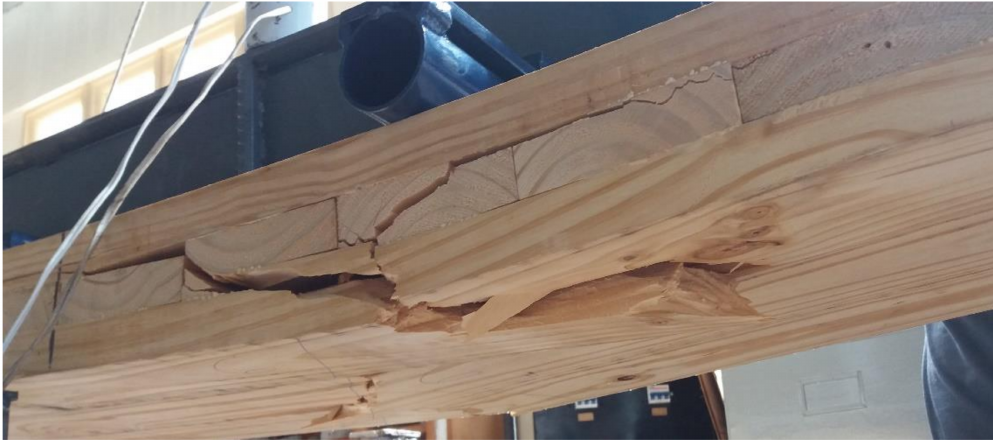
Figure 6. Tensile failure on the bottom of the CLT followed by rolling shear